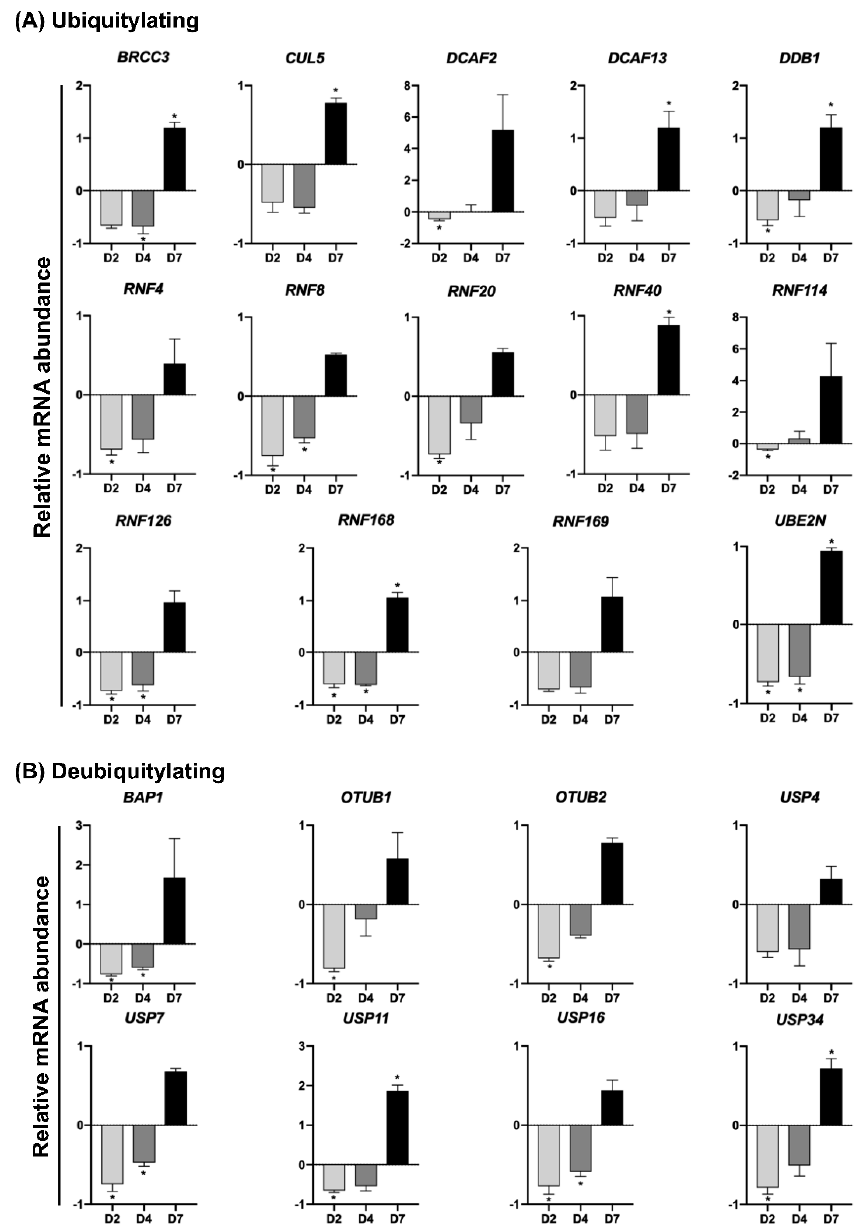
Figure 4. Relative mRNA abundance of genes encoding ubiquitylation ( A ) and deubiquitylation ( B ) enzymes in porcine embryos treated with UV at different stages of development. The abundance of transcripts is presented in relation to the levels observed in control embryos (not treated with UV) at the same developmental stage. D2, day 2 embryos; D4, day 4 embryos; D7, day 7 blastocysts. Asterisks indicate statistical differences ( p < 0.05) between control and UV-treated